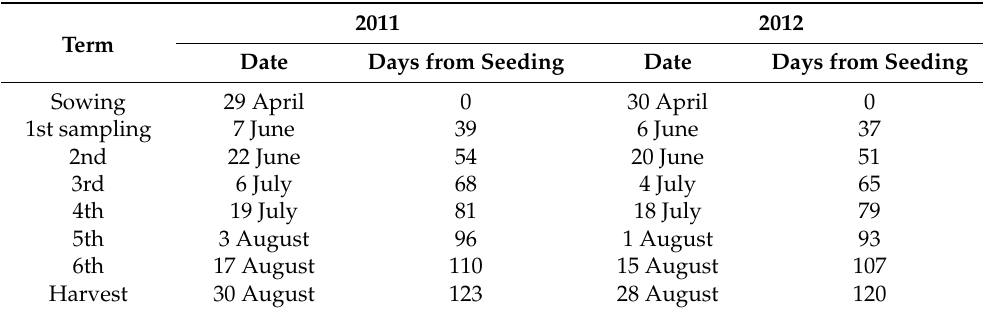
Table 2. Dates of sowing, sampling, and harvest and number of days from seeding to individual terms of sampling and harvest in